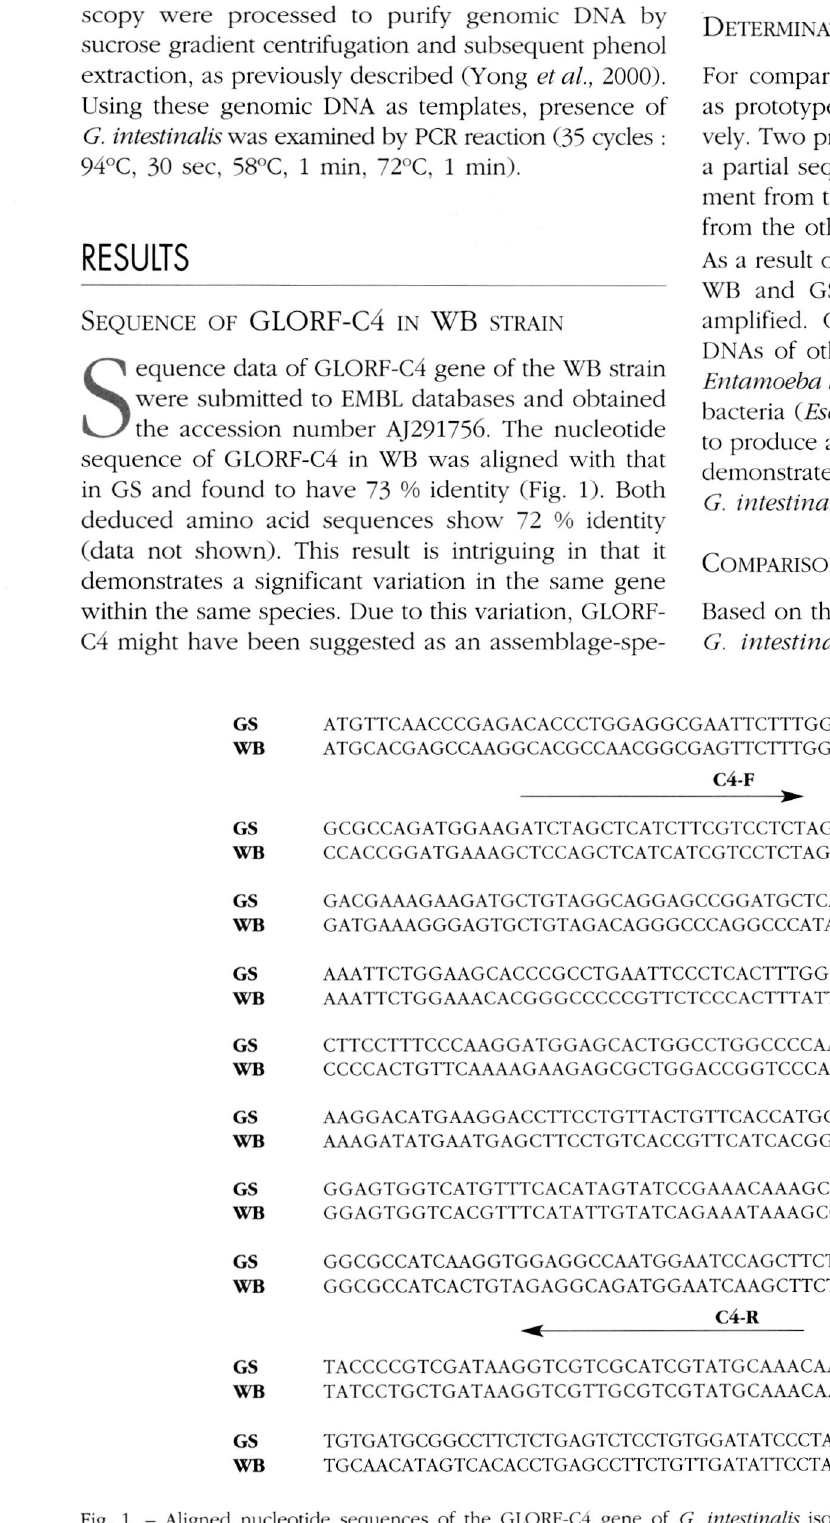
Fig. 1. - Aligned nucleotide sequences of the GLORF-C4 gene of G intestinalis isolate WB (assemblage A genotype; EMBL accession number AJ291756) and its putative ortholog (GenBank accession number M90390) from isolate GS, an assemblage B genotype. The seg­ ments corresponding to PCR primers C4-F and C4-R are indicated by